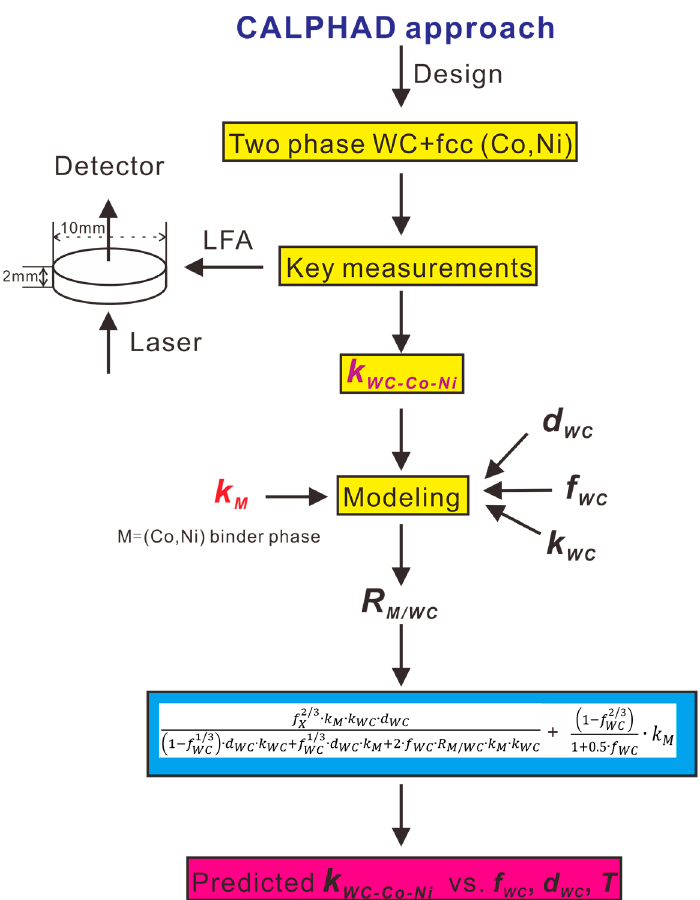
Figure 1. The overall strategy of the present work integrating experiments and models. k WC and k M represent thermal conductivity for WC phase and M binder phase, respectively. d WC represents grain size of WC while f WC is volume fraction of WC. R M/WC represents ITR (Interface Thermal Resistance) between the WC phase and the binder phase.